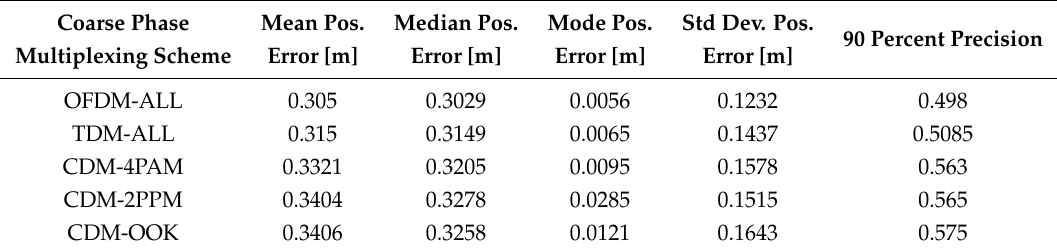
Table 6. Comparison among TDM, CDM, and OFDM in Coarse